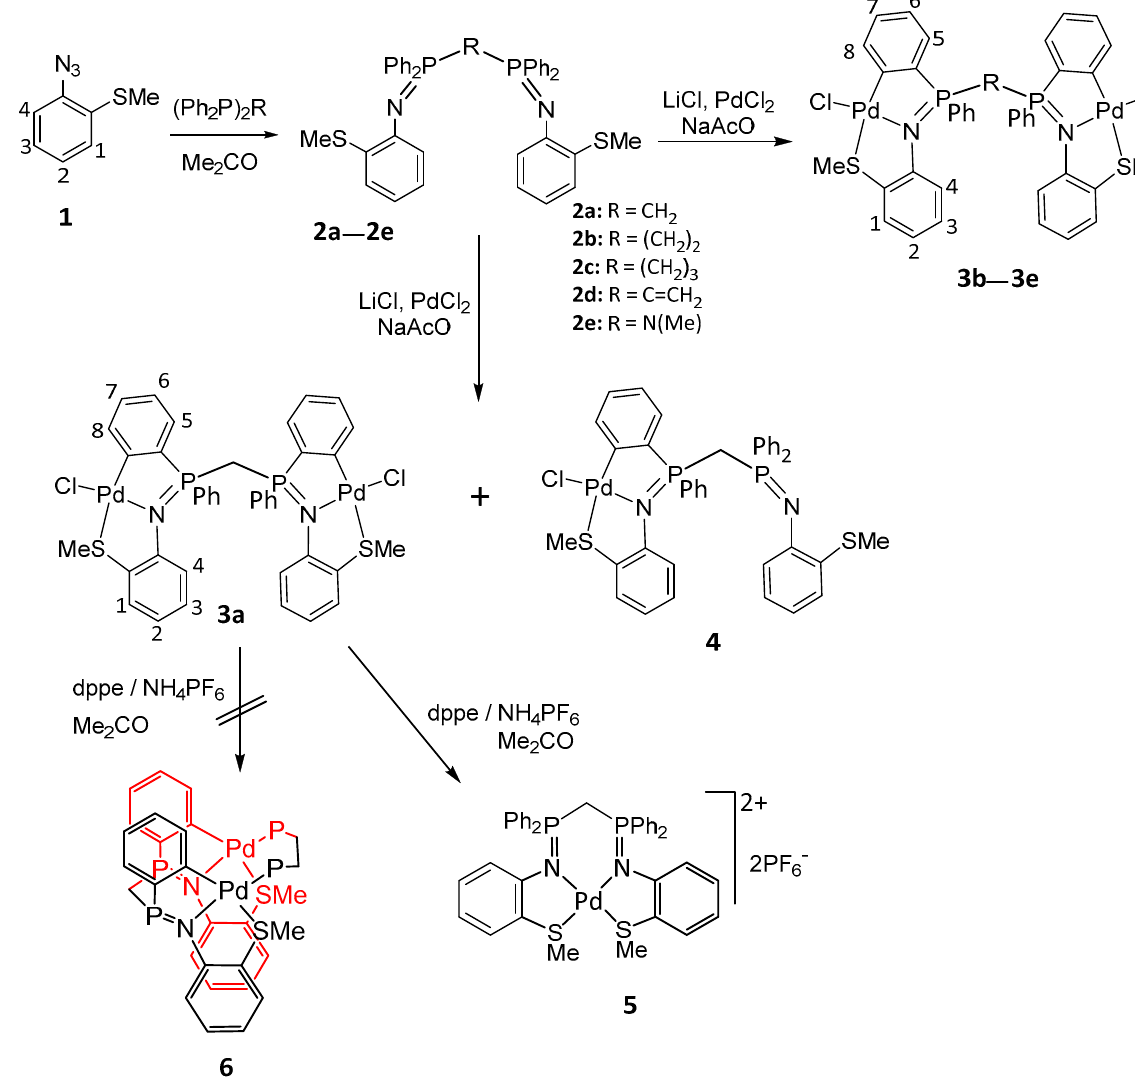
Scheme 2. Reaction sequence leading to the synthesis of double iminophosphorane palladacycles. Phenyl rings on the phosphorus atoms in 6 have been omitted for clarity.